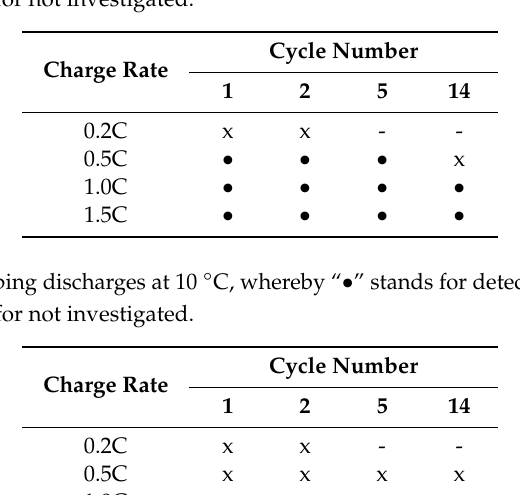
Table 4. Results of stripping discharges at 0 ◦ C, whereby “ • ” stands for detected, “x” for not detected lithium plating and “-” for not investigated.